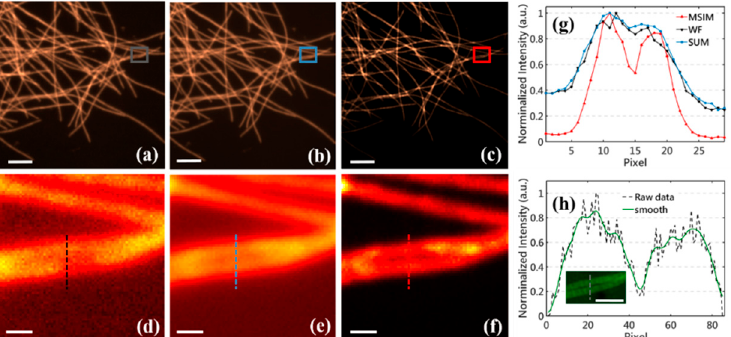
Figure 6. Nine raw multifocal images ( a – i ) of the fixed sample of Melosira. Scale bars: 40 μ m.